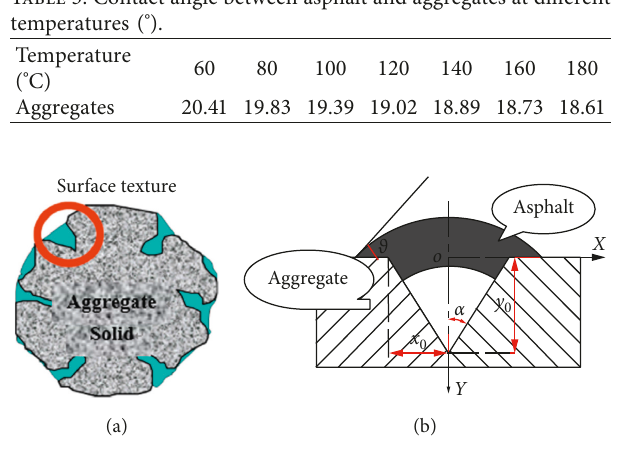
Figure 2: Aggregate surface texture and the model of asphalt infiltrating into aggregates. (a) Aggregate surface; (b) simplification of aggregate surface